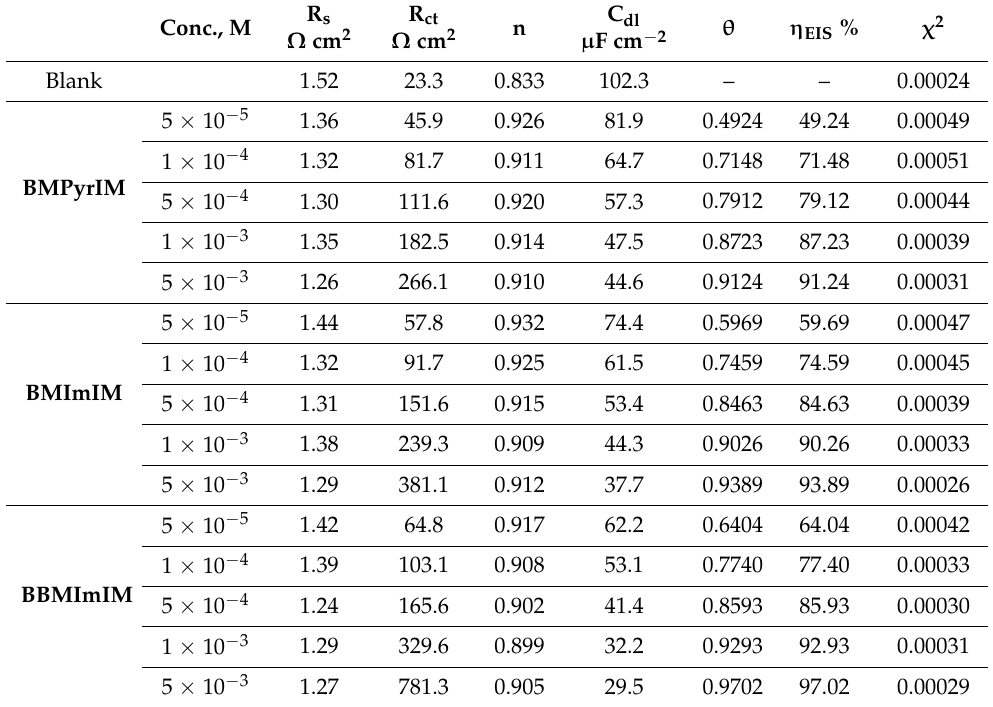
Table 4. Data attained by electrochemical impedance spectroscopy (EIS) technique for the corrosion of mild steel alloy in 1.0 M HCl in the absence and presence of different concentrations of the studied ILs at 25 ◦ C. χ 2 is the goodness of the fit. Conc., M Blank –